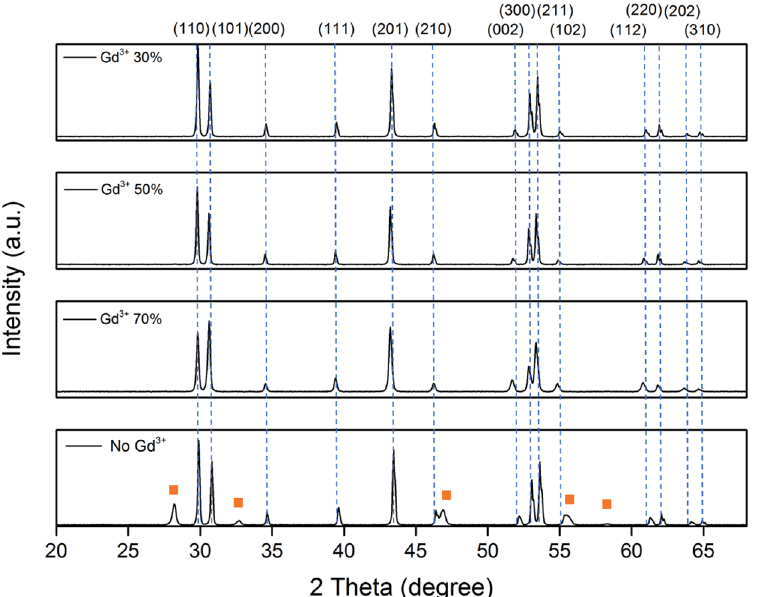
Figure 2. XRD patterns of NaYF 4 doped with 0 mol%–70 mol% ions and synthesized by a hydrothermal method heated under 200 for 20 hours. The orange squares represent cubic phase of NaYF 4 while the remaining diffraction peaks represent hexagonal phase.